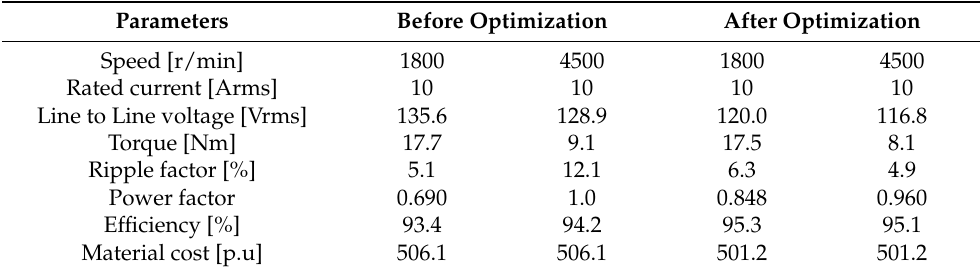
Table 2. Results of designs before and after optimizing the process with LPM.